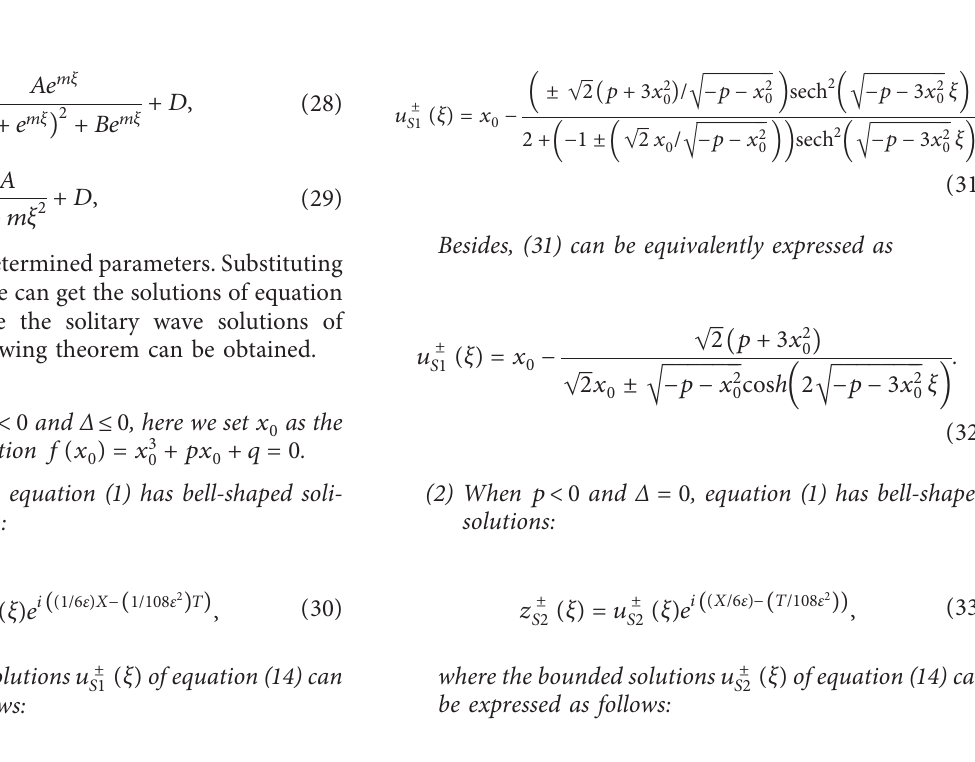
Figure 1: (a) q � 0 , Δ< 0, (b) q > 0 , Δ< 0, (c) q < 0 , Δ < 0, (d) q > 0 , Δ � 0, and (e) q < 0 , Δ �